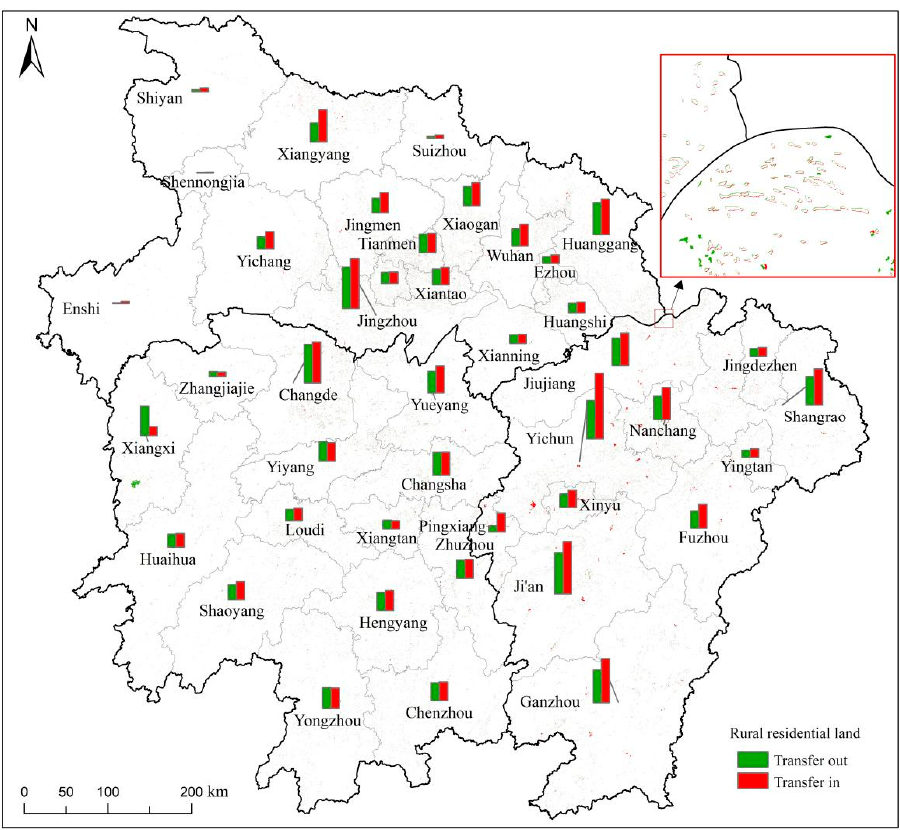
Figure 3. Transfer in and transfer out of RRL in 42 cities in the MRYR during 2000–2020.